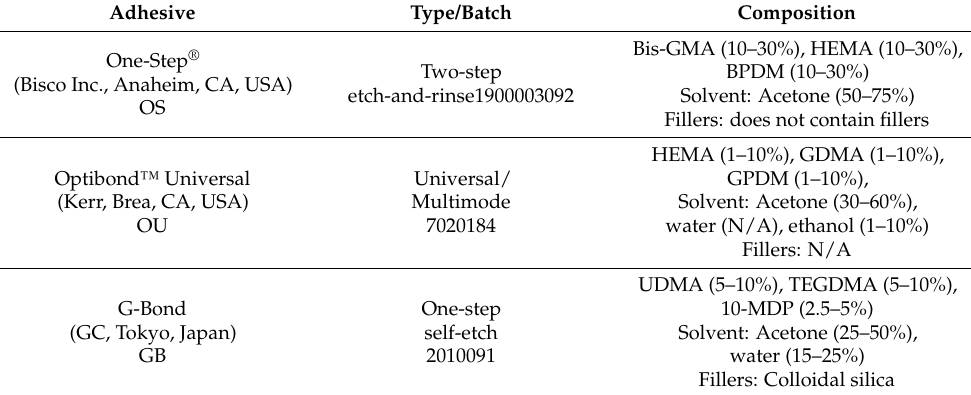
Table 1. Commercial adhesive types and their main monomers, solvents, and fillers, according to data provided by manufacturers and safety data sheets (percentages shown were given in the safety datasheets). N/A indicates manufacturers did not disclose range.